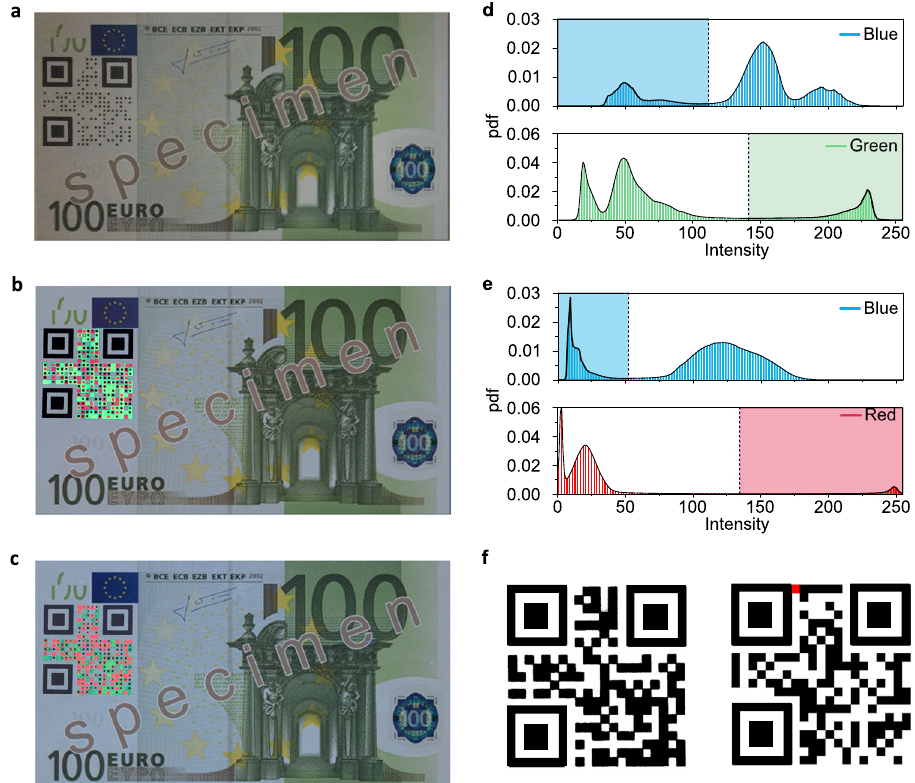
Fig. 3 Multiplexed luminescent QR code based on s -modules printed on banknote specimens. a Black QR code printed directly on top of a 100 € banknote specimen under daylight illumination. The QR code is fully visible and ready to be accessed. b , c Images of the banknotes under 254 nm and 365 nm excitation, respectively, displaying the Tb 3 + based QR code (green) and Eu 3 + based QR code (red). d Blue and green coordinates histogram and e blue and red coordinates histogram for QR codes displayed in ( b ) and ( c ), respectively, with the decision level marked. The shaded areas are the modules colour coordinates of interest for identi fi cation. f Decoded QR codes obtained from the decision level of ( d ) and ( e ). The red square in ( f ) is one misinterpreted module. The images in a – c are not real images; they are digital montages; whose only purpose is to illustrate a possible